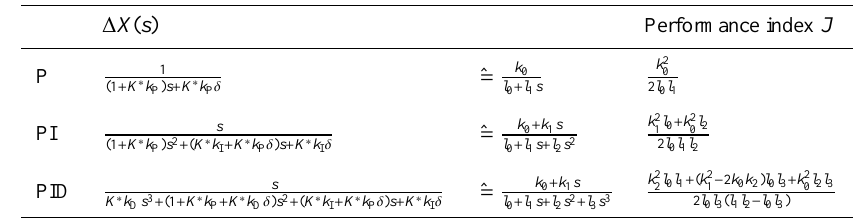
Table B2. Compensation deviation ∆ X ( s ) as a function of the controller parameters for the three controller types and the rules for the calculation of the ISE performance index J according to Newton et al.